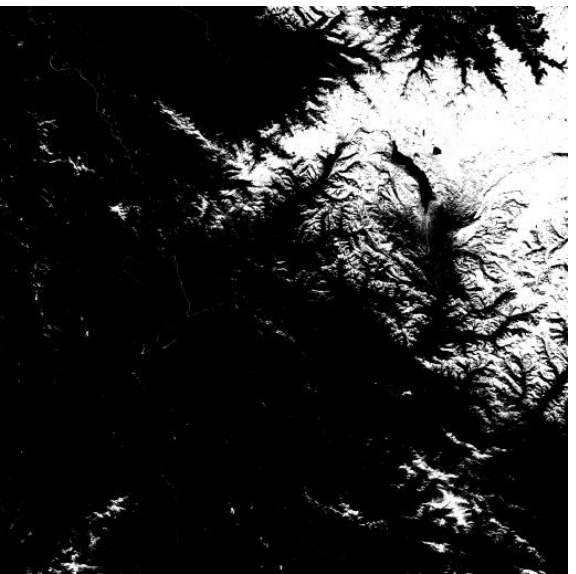
Figure 4. Ausangate Glacier clustering outcome with K-Means algorithm.